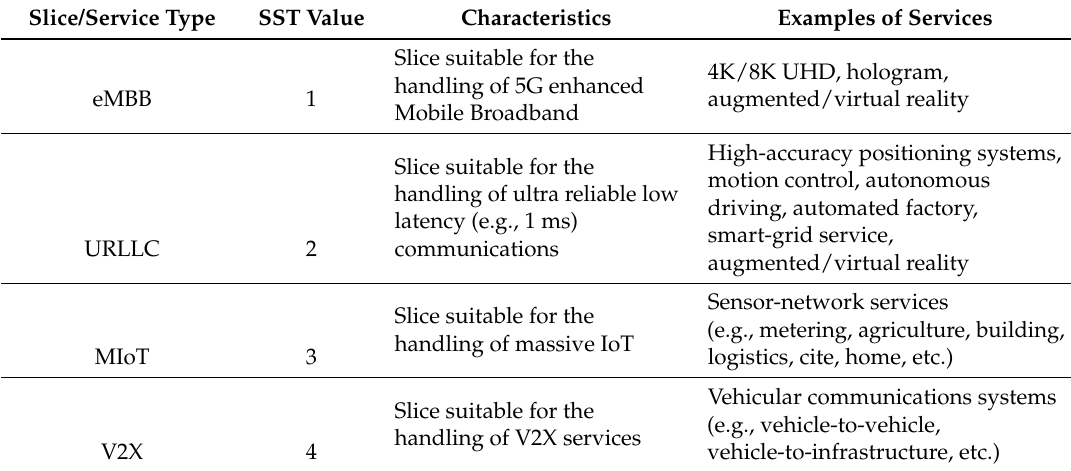
Table 1. Standardized SST values and examples